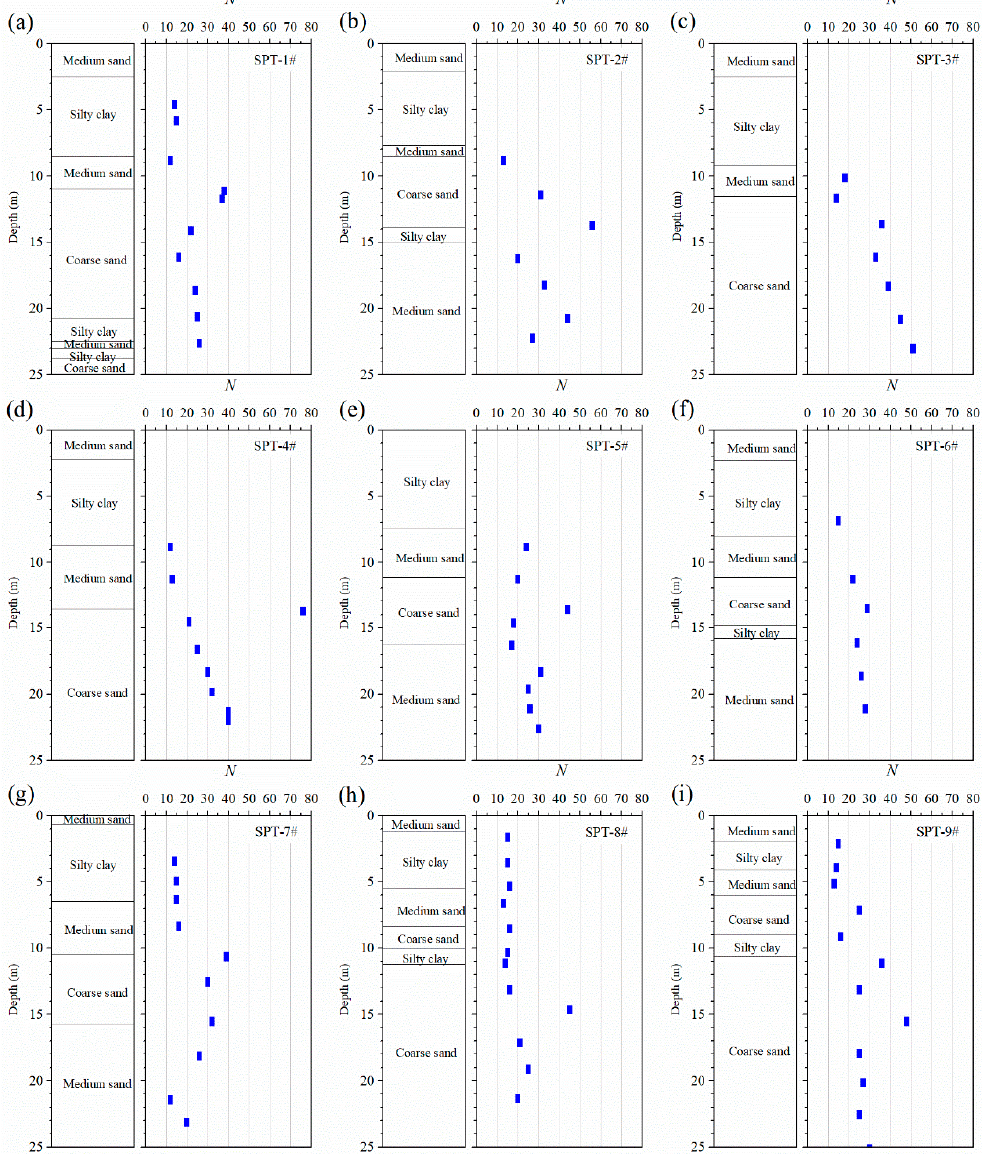
Figure 6. Soil profile and standard penetration test results (SPT-N). ( a ) SPT-1#; ( b ) SPT-2#; ( c ) SPT-